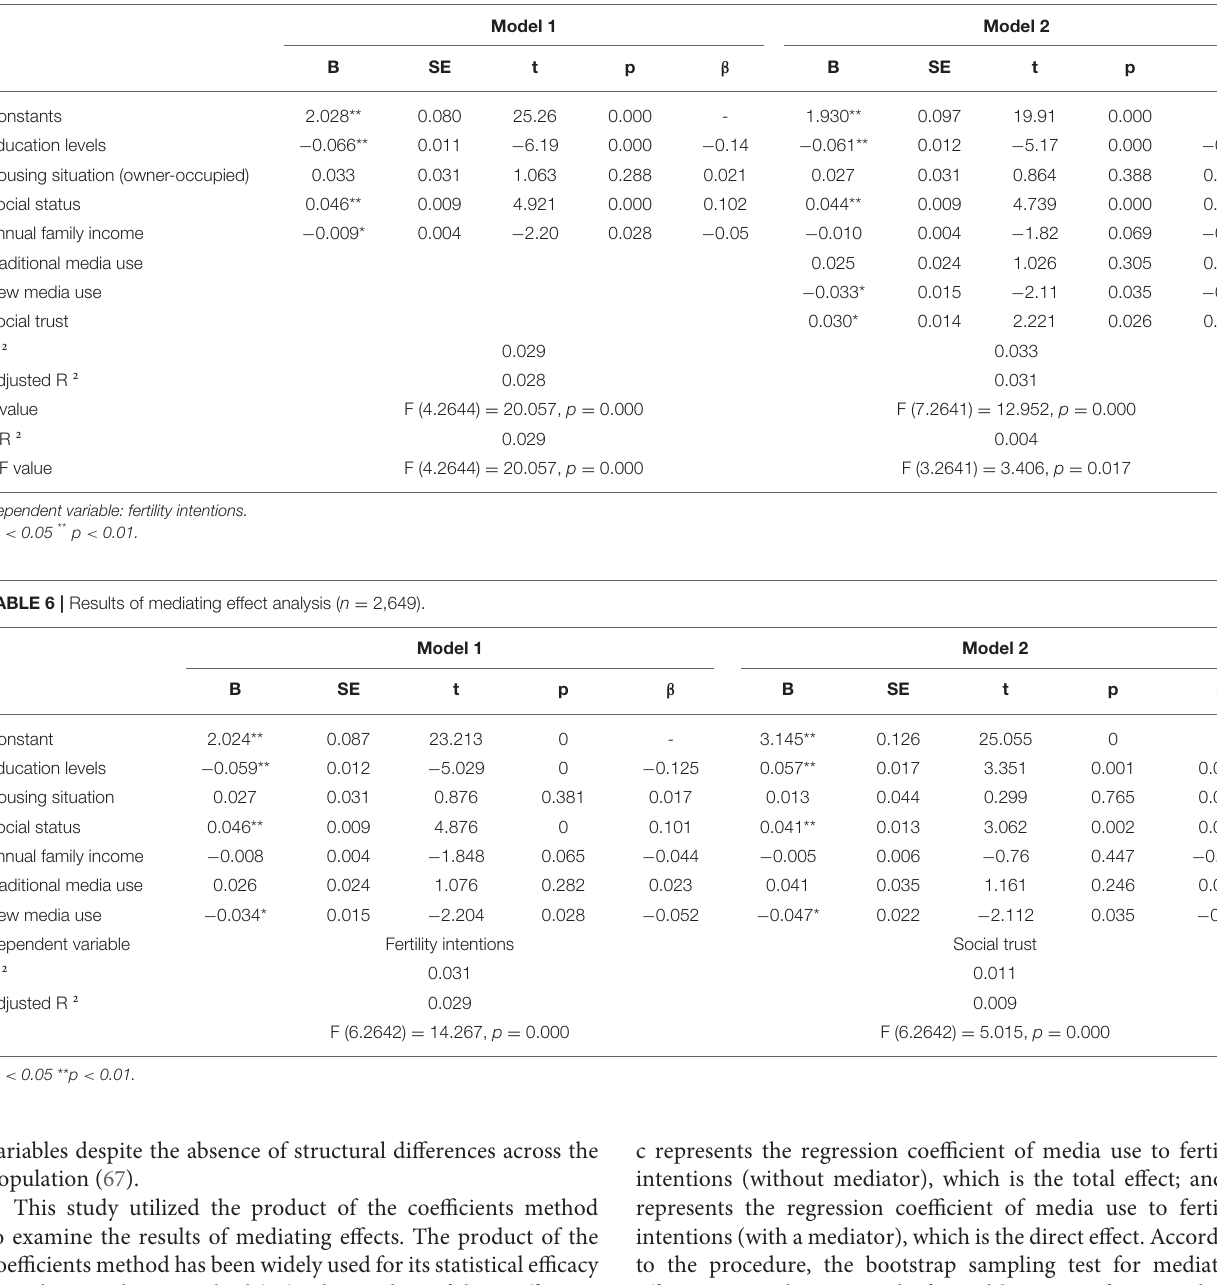
TABLE 5 | Results of hierarchical multiple regression analysis ( n = 2,649).